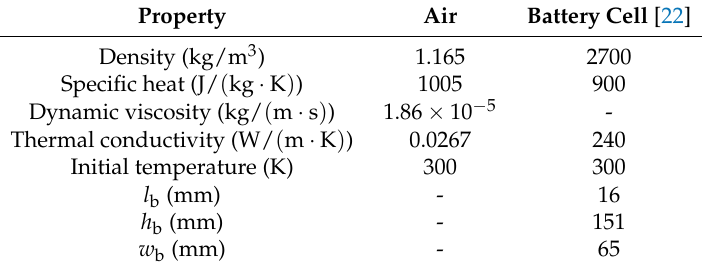
Table 1. Properties of the battery cell and